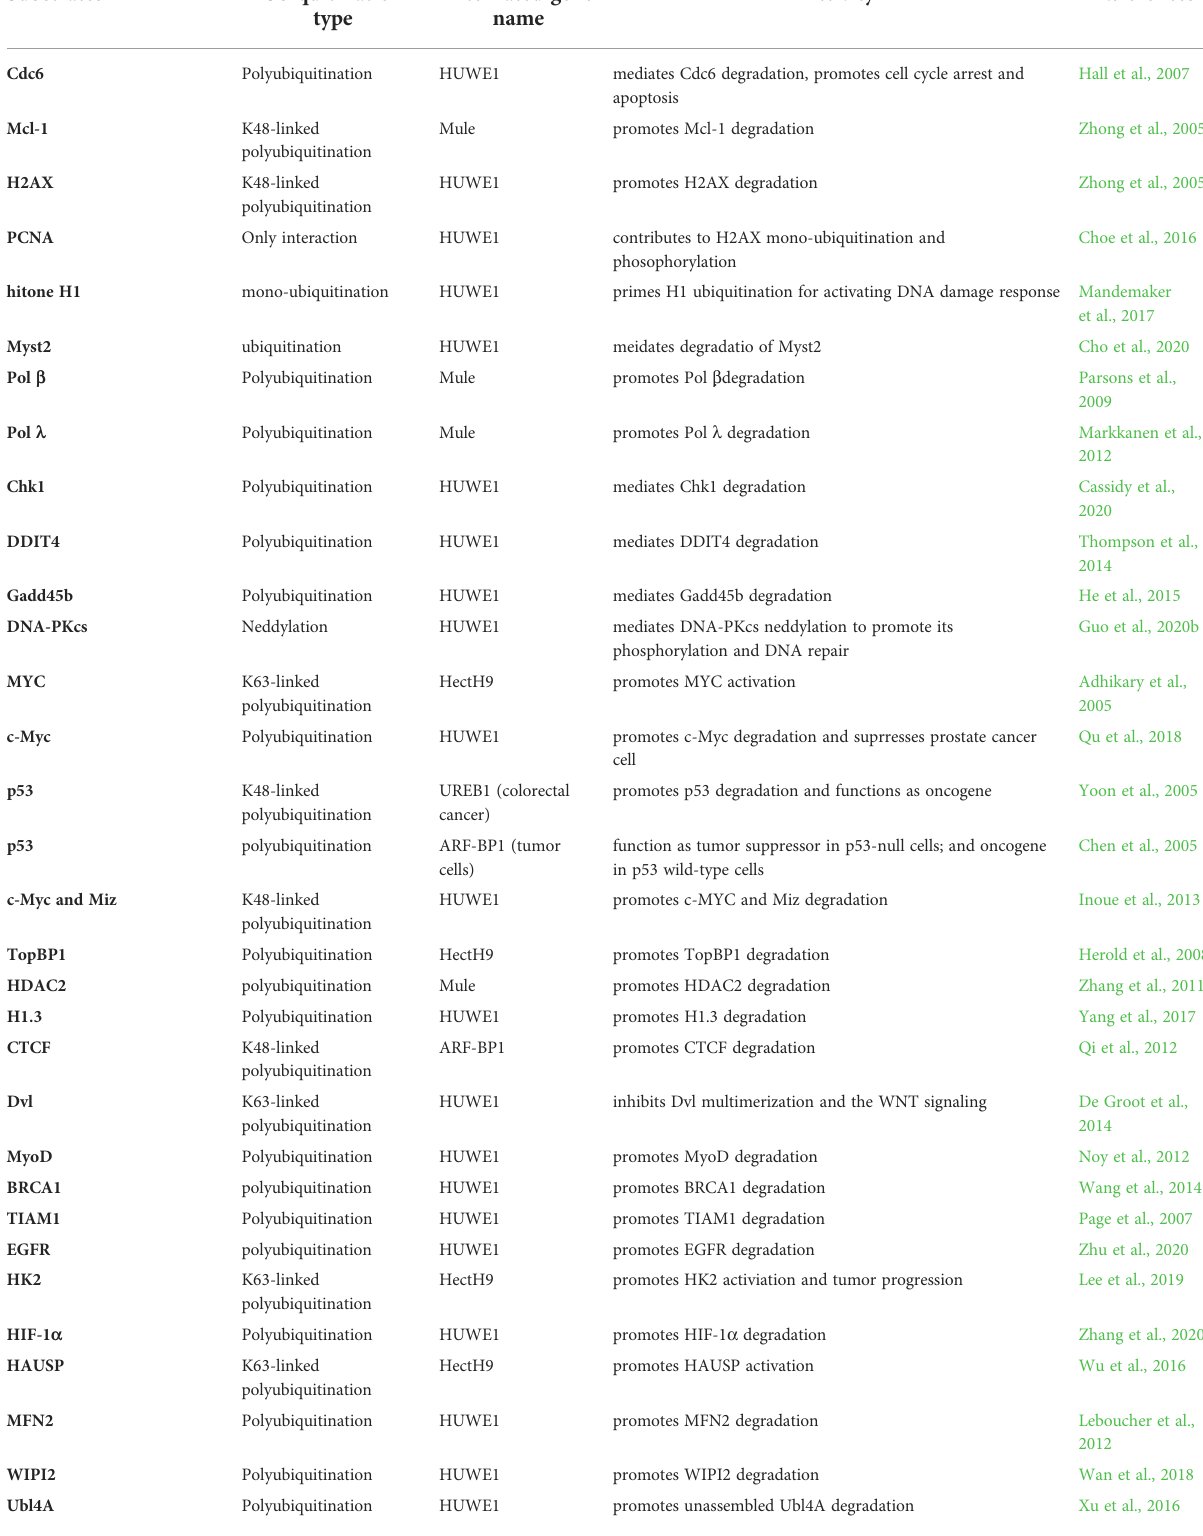
TABLE 1 Known Substrates of